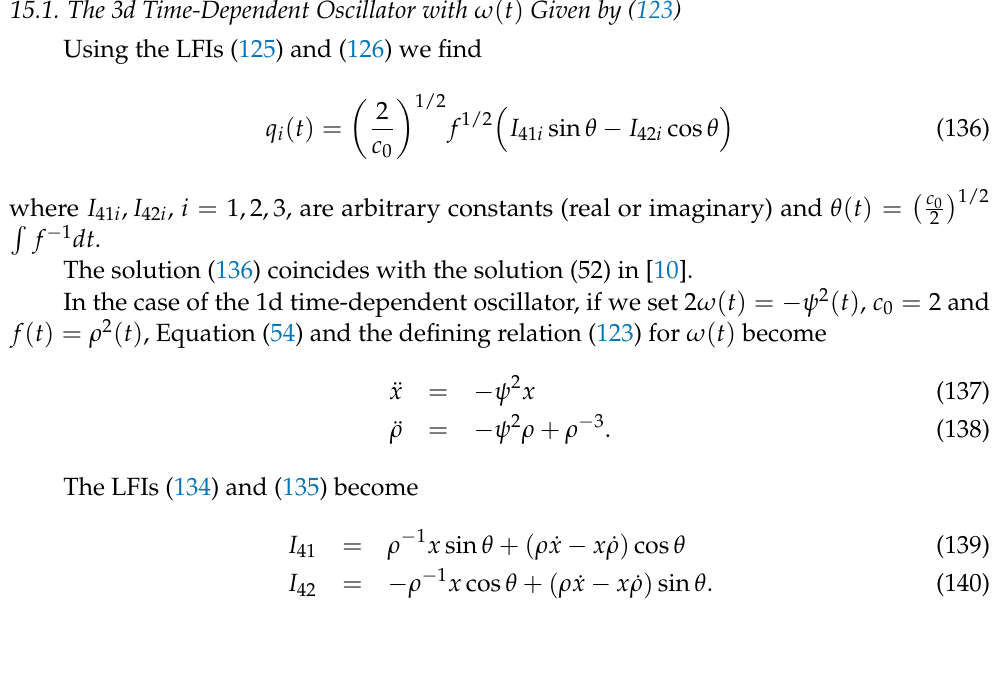
ν ω ( t ) LFIs and QFIs ∀ ∀ ν